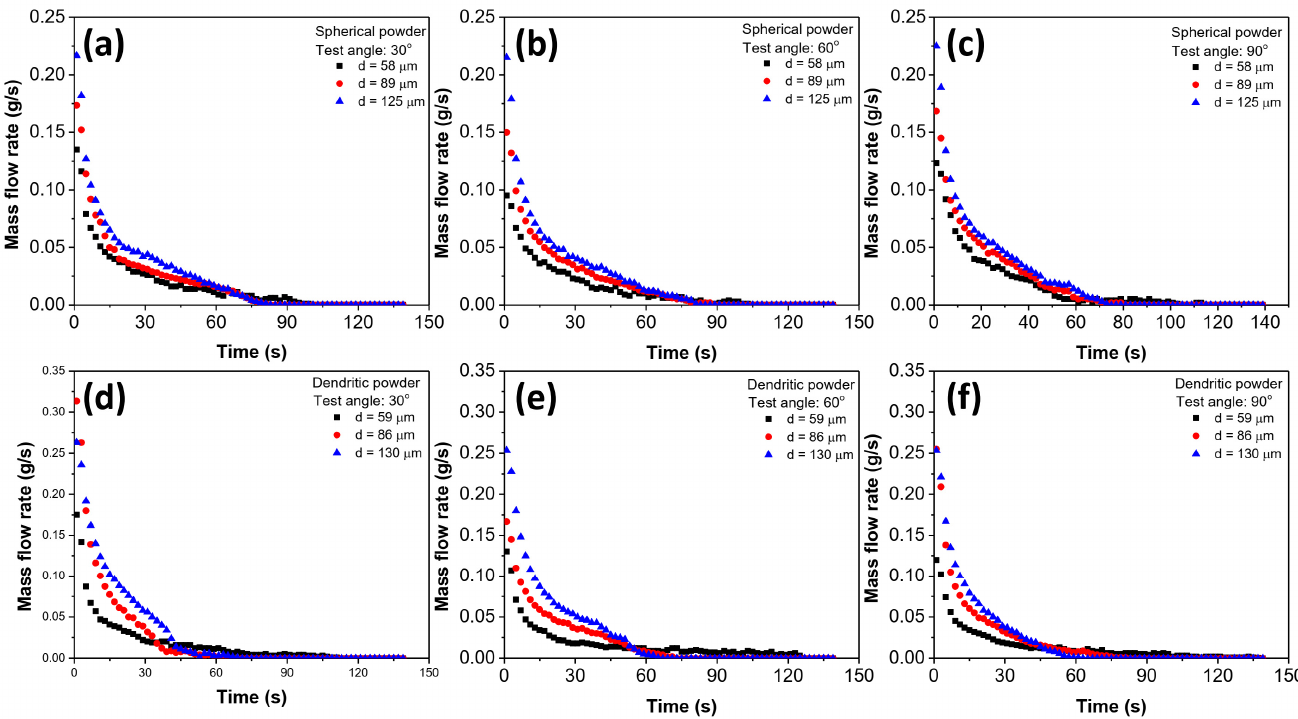
Figure 12. The mass flow rate of porous copper samples at different inclination angles ( a ) 30 o , ( b ) 60 o , ( c ) 90 o for spherical Cu powders and ( d ) 30 o , ( e ) 60 o , ( f ) 90 o for dendritic Cu powders.